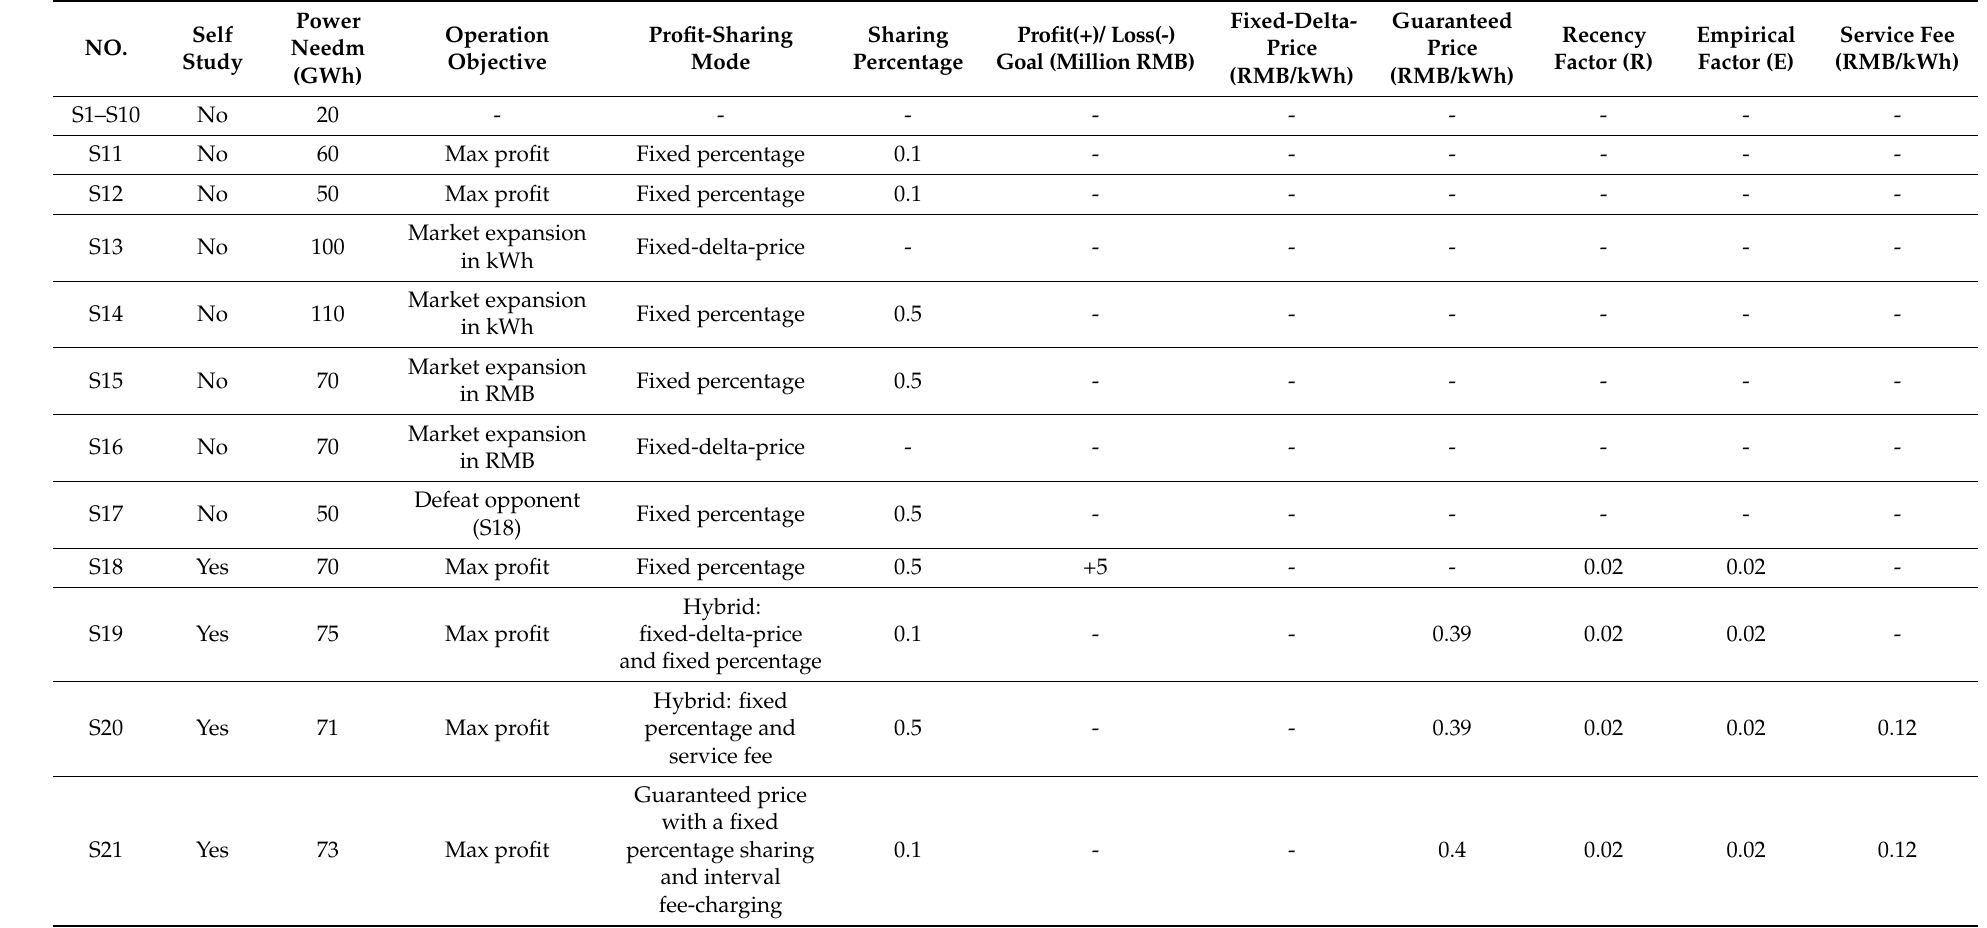
Table A2. Parameter settings for the